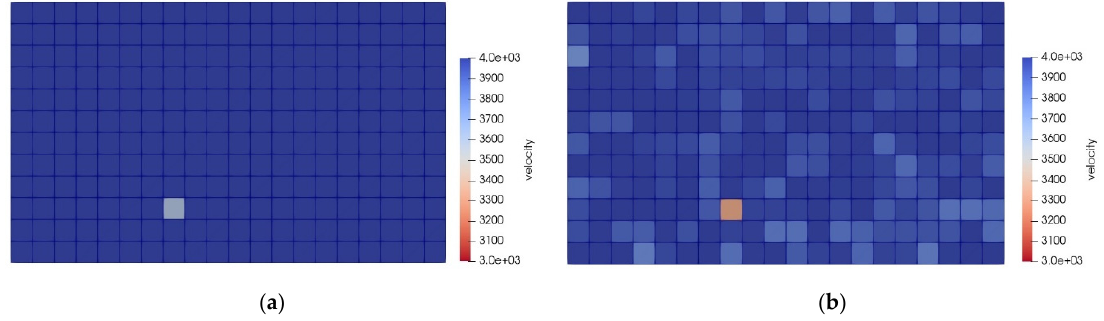
Figure 11. Identified results of case 1: ( a ) LASSO algorithm; ( b ) SIRT algorithm.